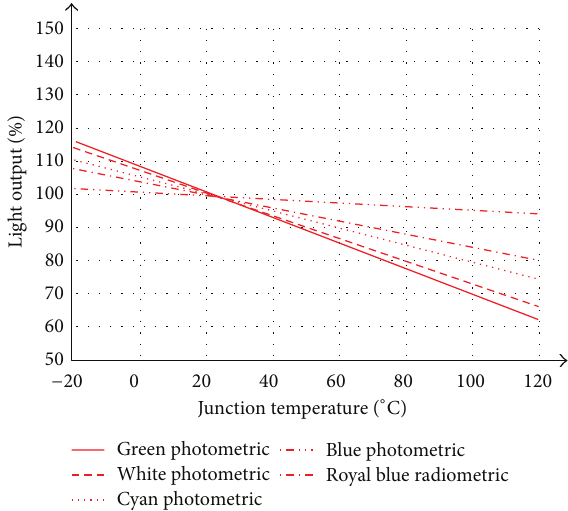
Figure 1: Relationship between the LED junction temperature and light